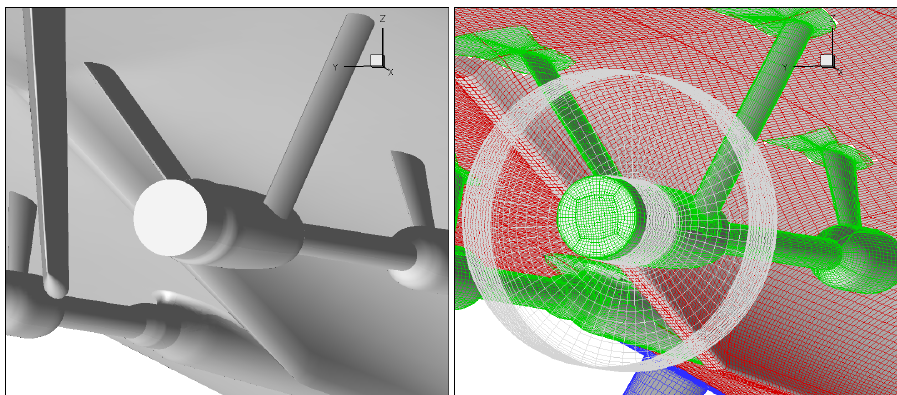
Figure 3. Model hull. ( Top ) Hull computational mesh. ( Bottom ) sketch of the computational mesh in the propeller region.